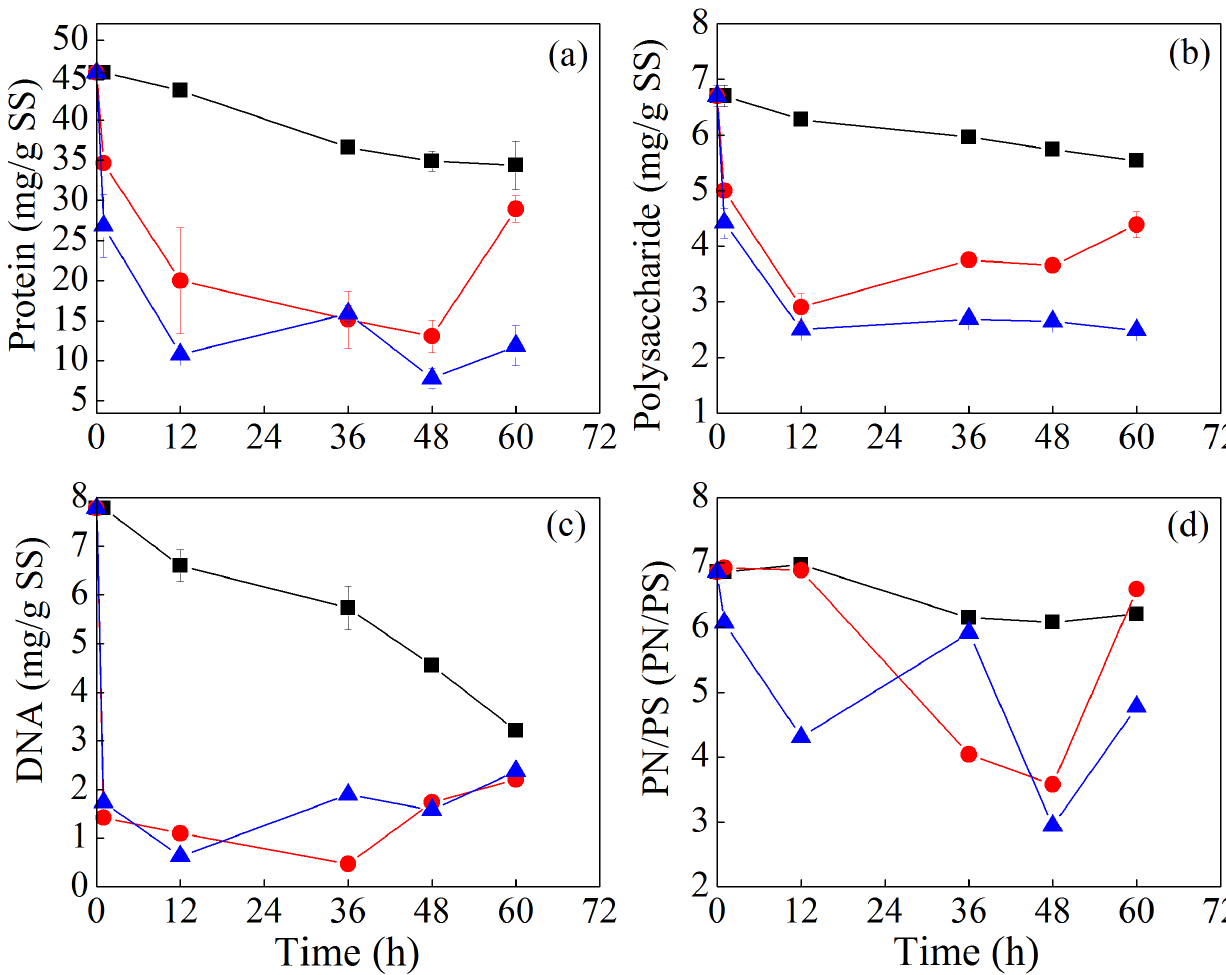
Figure 4. Variation of the content of protein (a), polysaccharide (b) and DNA (c), and PN/PS (d) in TB–EPS during sludge bioleaching process. (PN/PS: protein/polysaccharide) ( & CK1, # CK2, g A.t + A.f